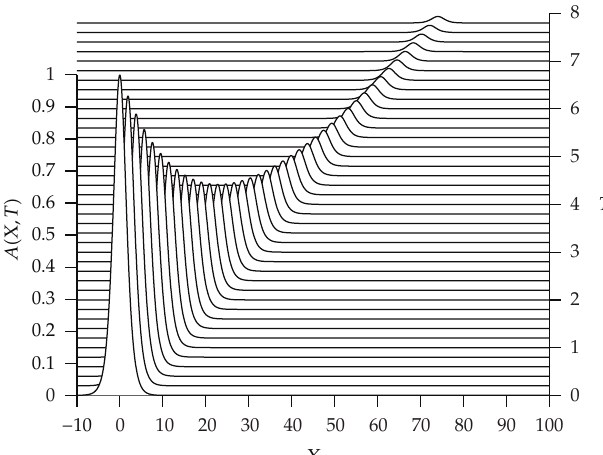
Figure 1: Perturbation solution of ILW-Burgers equation.